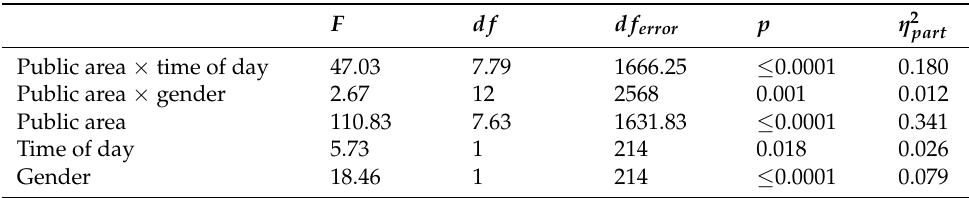
Table 2. Results of ANOVA with repeated measures.